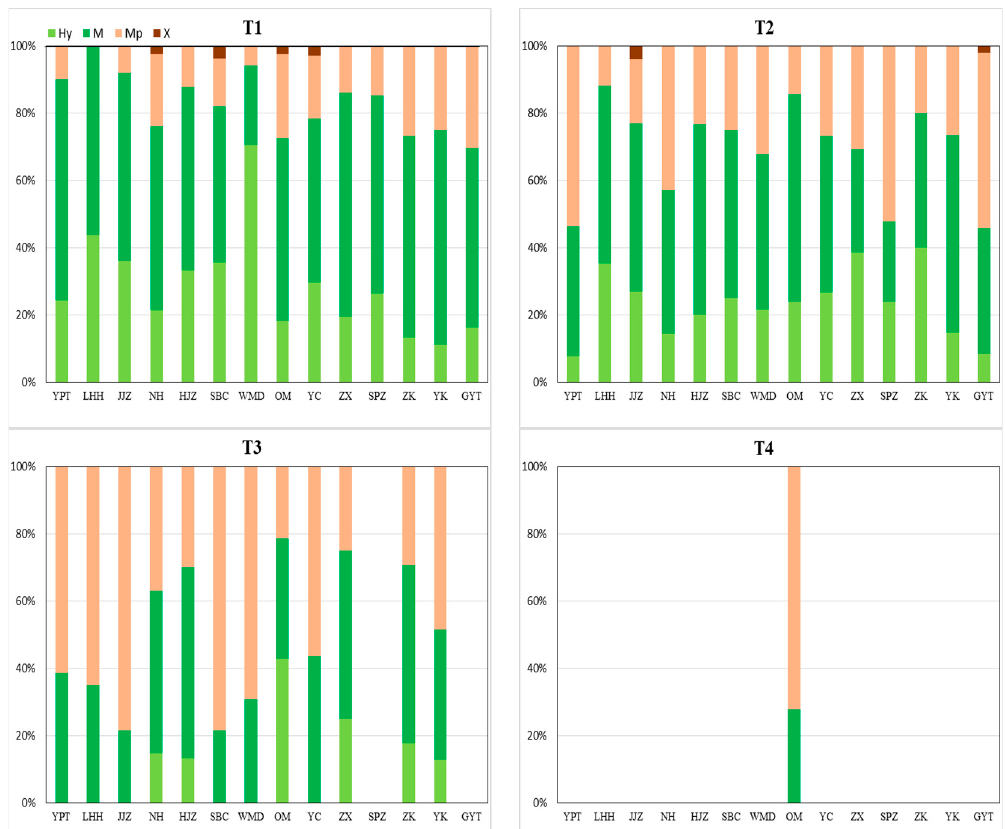
Figure 2. Plant hydrophilic types for four transects in each sampling site in the MLHR, China. Hy, hydric species; M, mesic species; Mp, mesophytes; and X, xerophytes. T1, 2, 3, and 4 represent the first, second, third, and fourth transect, respectively. YPT, Yangpitan; LHH, Lihuahu; JJZ, Jiangjiazhou; NH, Nanhu; HJZ, Hujiazhou; SBC, Shanbiancun; WMD, Wumingdao; OM, Oumiao; YC, Yicheng; ZX, Zhongxiang; SPZ, Shipaizhen; ZK, Zekou; YK, Yuekou; GYT, Guanyintang.